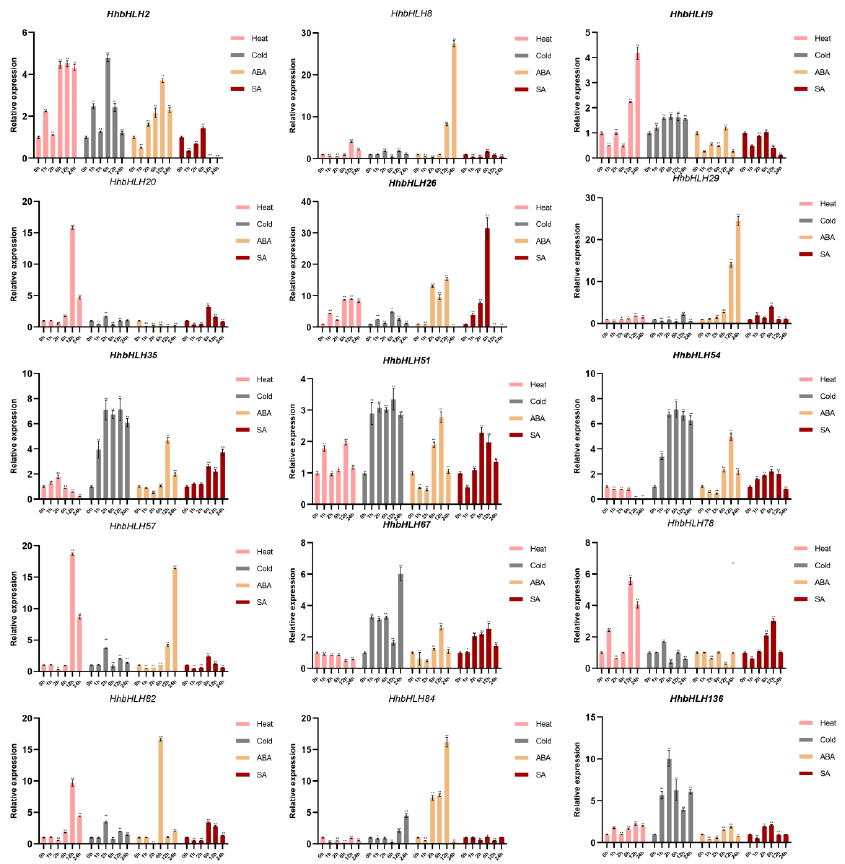
Figure 8. Expression profiles of 15 selected HhbHLH genes in response to various stress treatments. Different colors represent different stress treatments. Pink represents heat stress, gray represents cold stress, yellow represents ABA stress, and red represents SA stress. Asterisks denote genes that are significantly up- or down-regulated in comparison to the untreated control (* p < 0.05, ** p < 0.01, Student’s t